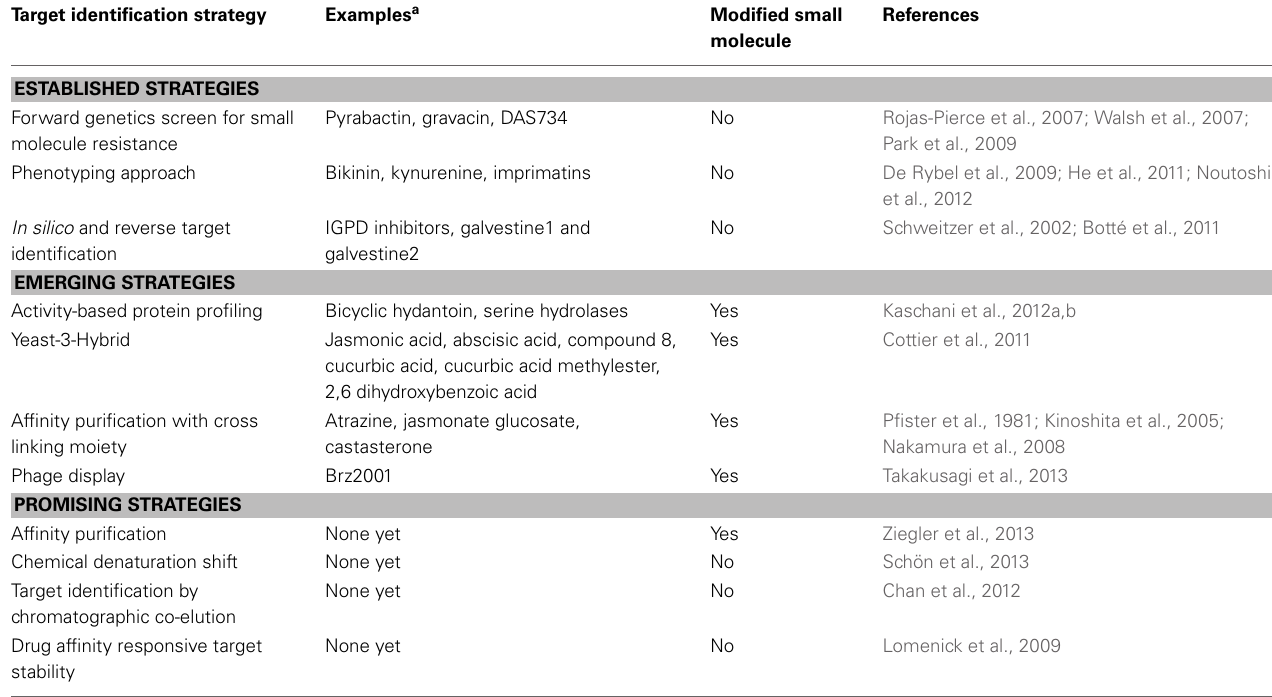
Table 1 | Overview of the target identification